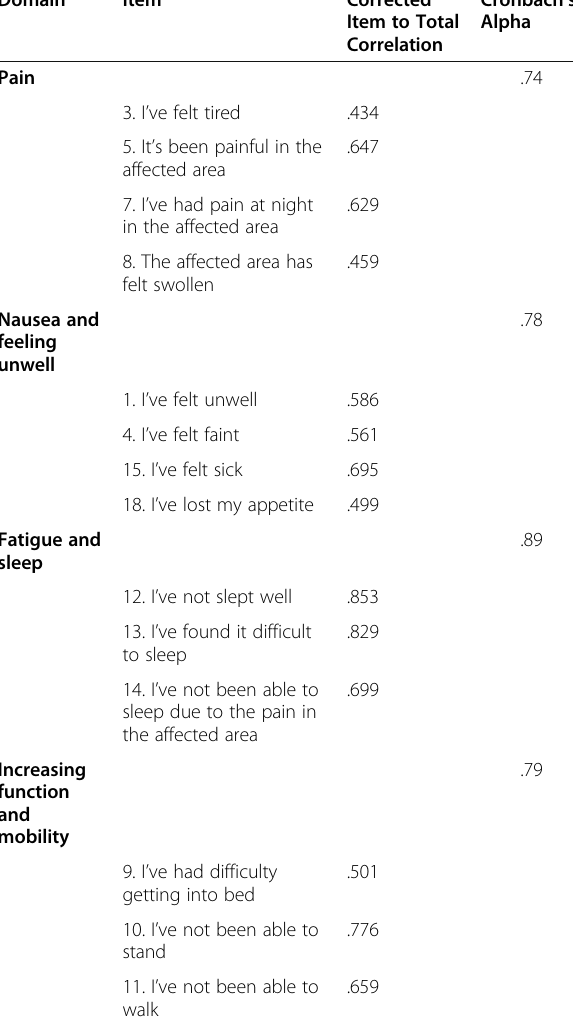
Table 7 Phase three day 1 14 item OARS item to total correlations and internal reliability Domain